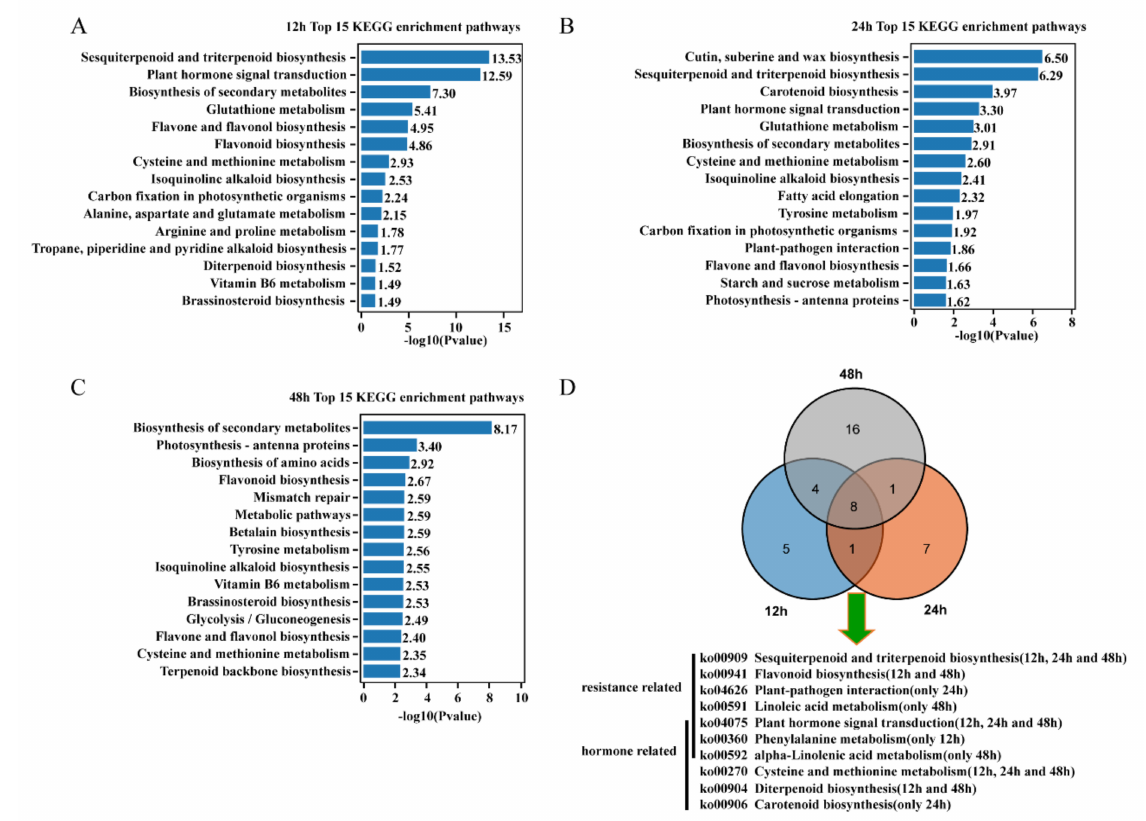
Figure 6. The KEGG enrichment pathway analysis of DEGs after treatment with 1 (cid:48) ,4 (cid:48) - trans -diol-ABA. Top 15 significant pathways at 12 h ( A ), 24 h ( B ), and 48 h ( C ), respectively. Data were visualized using a bar plot with the p -value level indicated by ‘ − log 10 ( p value)’. ( D ) Venn diagram showing the overlap of common and unique pathways present in the transcriptome at 12, 24, and 48 h. The resistance- and hormone-related KEGG pathways for three time points is